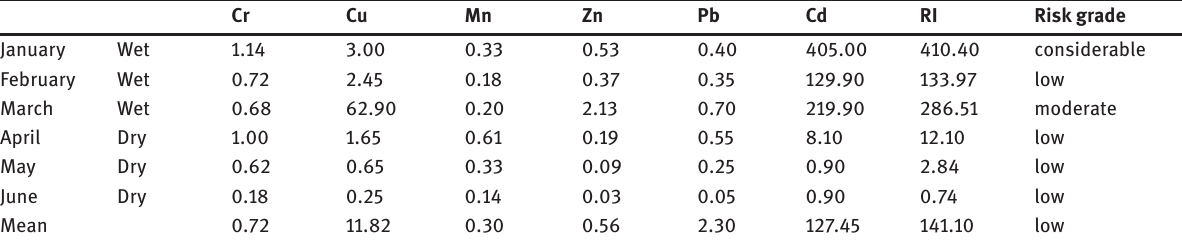
and RI of trace metals in Nzhelele River r